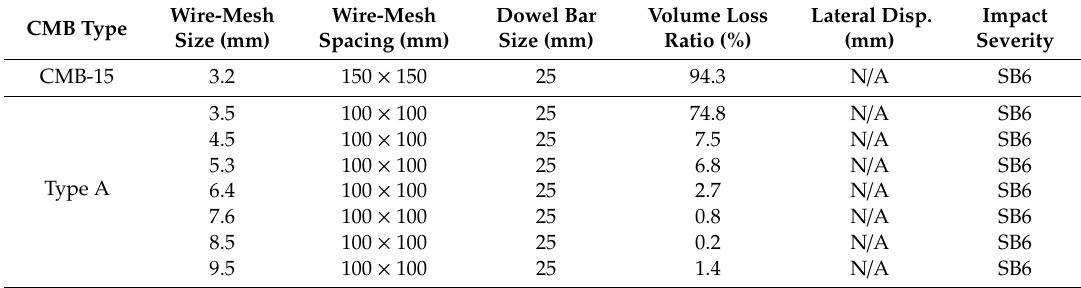
Figure 4. Current CMB (CMB-15) in service and the proposed Type A and Type B CMBs. ( a ) CMB-15; ( b ) fixed ordinary CMB (Type A); ( c ) deformable CMB with shock absorbers (Type B). Table 1. The obtained results depending on types of CMBs